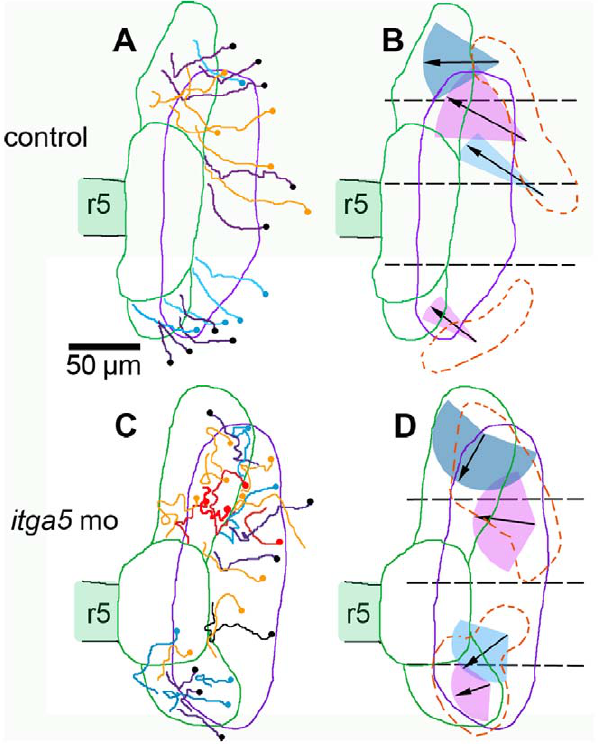
Figure 3. Trajectories of non-otic cells tracked in reverse. ( A, C ) Maps showing the trajectories of GFP positive cells pooled from the time-lapse movies in Fig. 2 of control embryos (A) and itga5 morphants (C). Trajectories in orange indicate cells originally tracked by coexpres- sion of GFP and RFP. All other trajectories represent cells tracked retrospectively by GFP alone. Dots indicate origins of tracked cells. Trajectories in red denote cells that died during recording (C). ( B, D ) Summaries of average migration patterns on non-otic cells in different quadrants in control embryos (B) and itga5 morphants (D). The mean length of net displacement (arrows) and range of angle of net displacement (colored cones) are indicated. The dashed orange lines indicate regions from which non-otic cells originated. Initial and final positions of the pax2a:GFP domain are represented by the purple and green boundaries, respectively. The position of rhombomere 5 (r5) is indicated. Lateral is to the right and anterior is to the top. Scale bar, 50 m